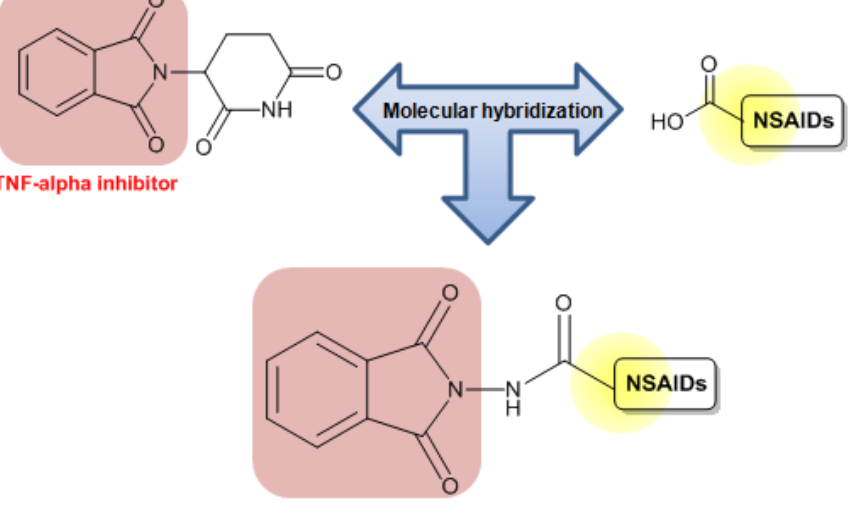
Figure 8. General structures of NSAID hybrids with COX and TNF- α inhibiton